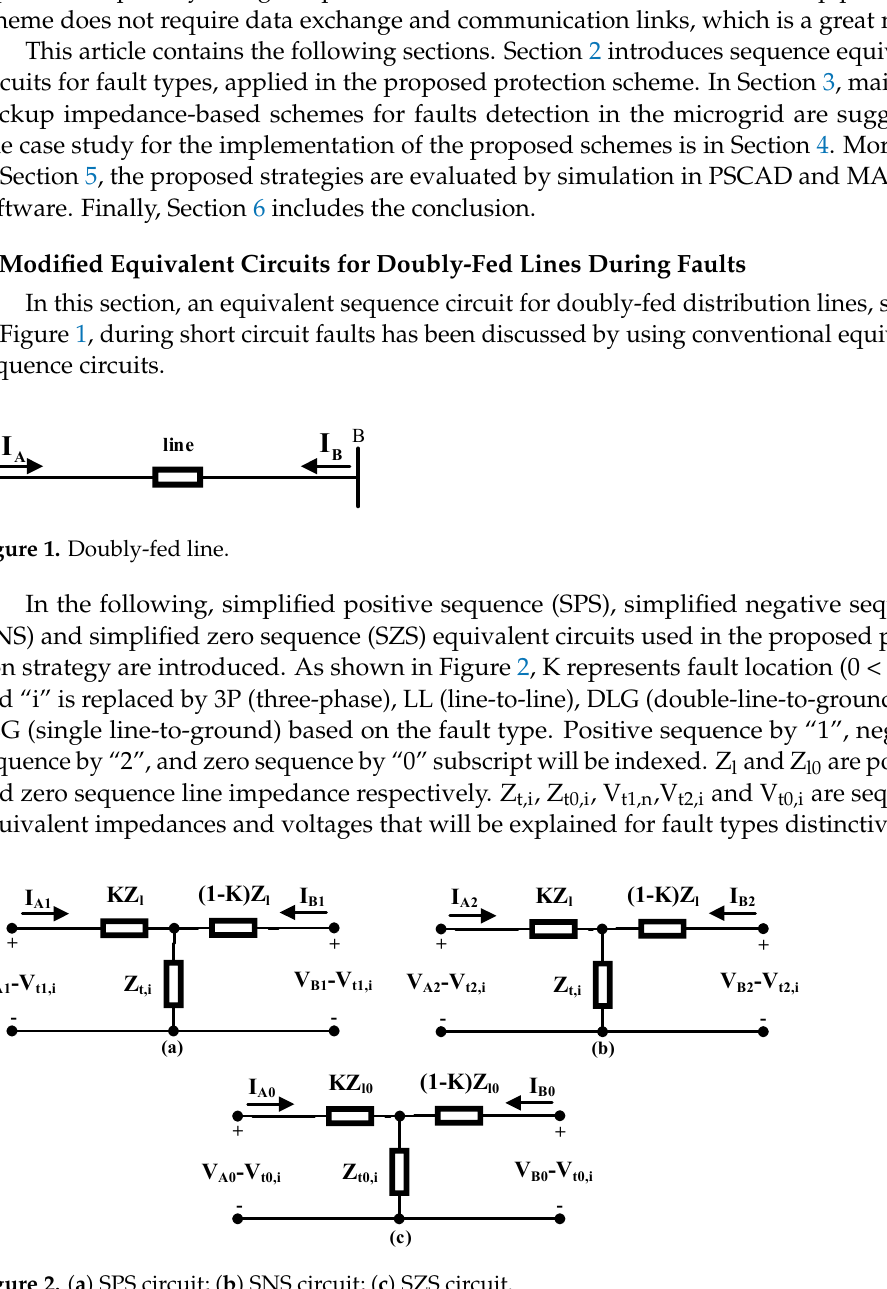
Figure 2. ( a ) SPS circuit; ( b ) SNS circuit; ( c ) SZS circuit.